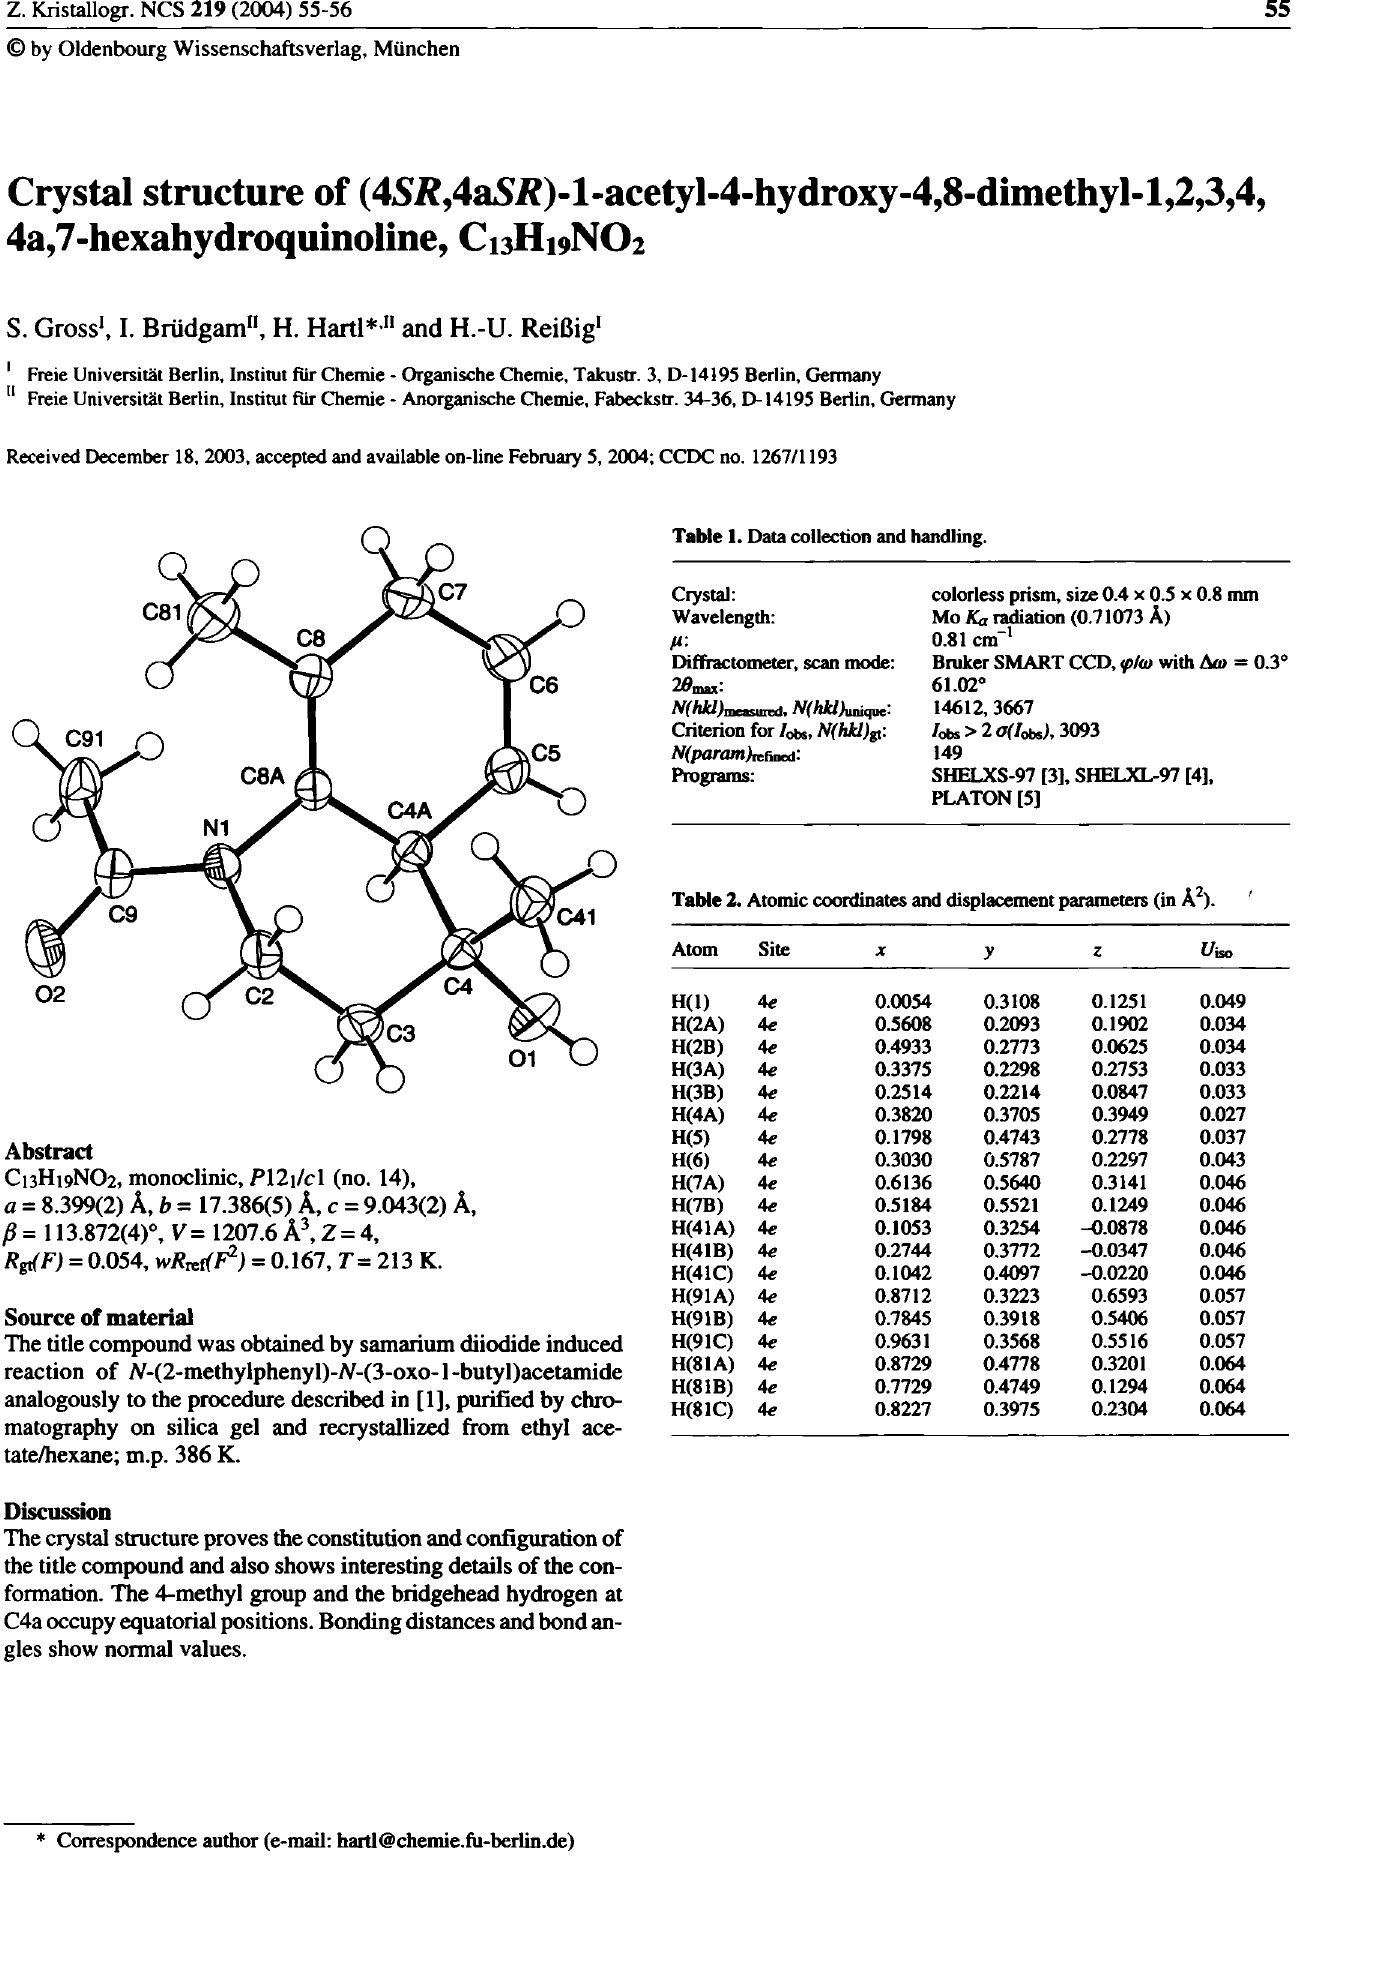
Table 2. Atomic coordinates and displacement parameters (in Ä 2